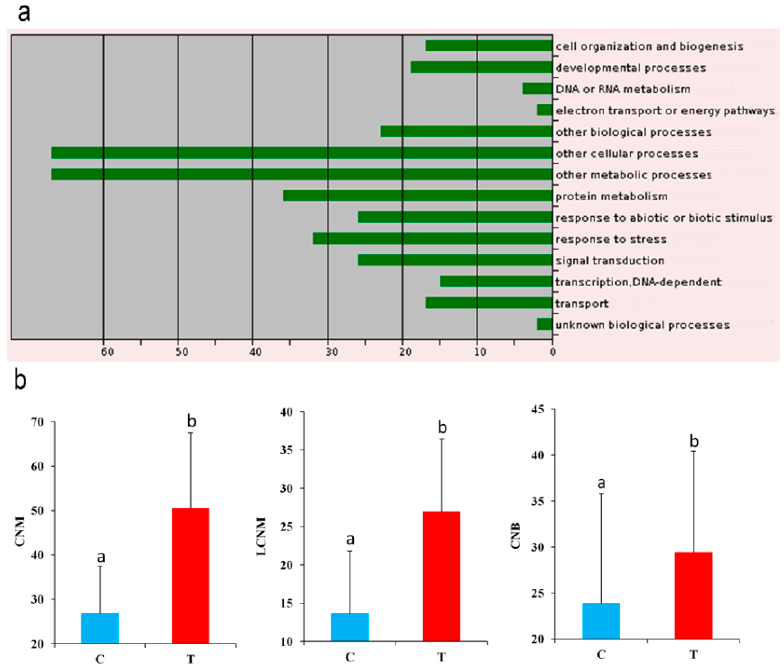
Figure 7. Functional analysis of 48 candidate gene-containing significant SNPs. ( a ) Biological function of the SNP-containing genes. ( b ) Identification of the favorable allele for the gene SiACS8 . 262 genotypes harboring the C allele and 420 harboring the T allele were used. Different letters above bars represent significant difference ( p < 0.05) between genotypes. The error bar indicates the standard error of the mean. Definition of the labels can be found at the end of this article.